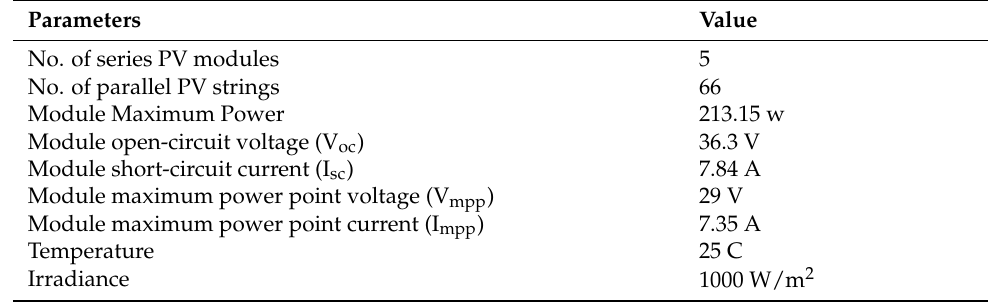
Figure 4. PV solar array at 1 kW/m 2 , 0.6 kW/m 2 , and 01 kW/m 2 for the ( a ) I–V curve and ( b ) P–V curve. Table 2. Specifications of the PV system.